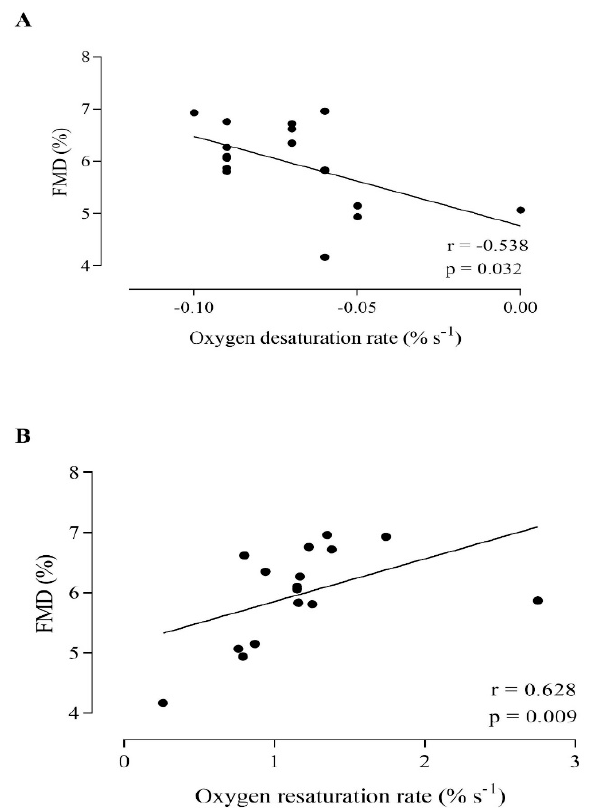
Figure 1. Correlation between the femoral artery flow-mediated dilation (FMD) and tibial anterior desaturation rate ( A ) and resaturation rate ( B ) in healthy, young individuals.